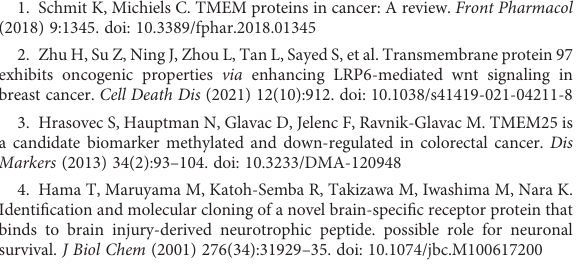
SUPPLEMENTARY TABLE 1 COX aggression analysis of transcriptome with disease-speci fi c survival. SUPPLEMENTARY TABLE 2 COX aggression analysis of transcriptome with progression-free interval. SUPPLEMENTARY TABLE 3 Prognosis-associated gene list SUPPLEMENTARY TABLE 4 TMEM106C expression and clinicopathological parameters in prostate cancers. SUPPLEMENTARY TABLE 5 TMEM225B expression and clinicopathological parameters in prostate cancers. SUPPLEMENTARY TABLE 6 TMEM272 expression and clinicopathological parameters in prostate